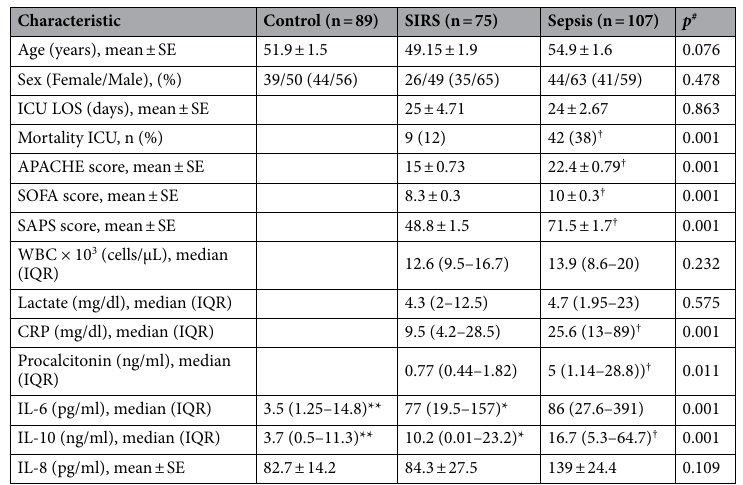
Table 1. Patients demographics and clinical characteristics. # Differences among groups ( ANOVA, Kruskal– Wallis, x 2 test , as appropriate): Post hoc differences: *control-SIRS, **control-sepsis, † SIRS-sepsis. SIRS systematic inflammatory response syndrome, IQR interquartile ratio, ICU intensive care unit, LOS length of stay, WBC white blood cells, CRP C-reacting protein, IL